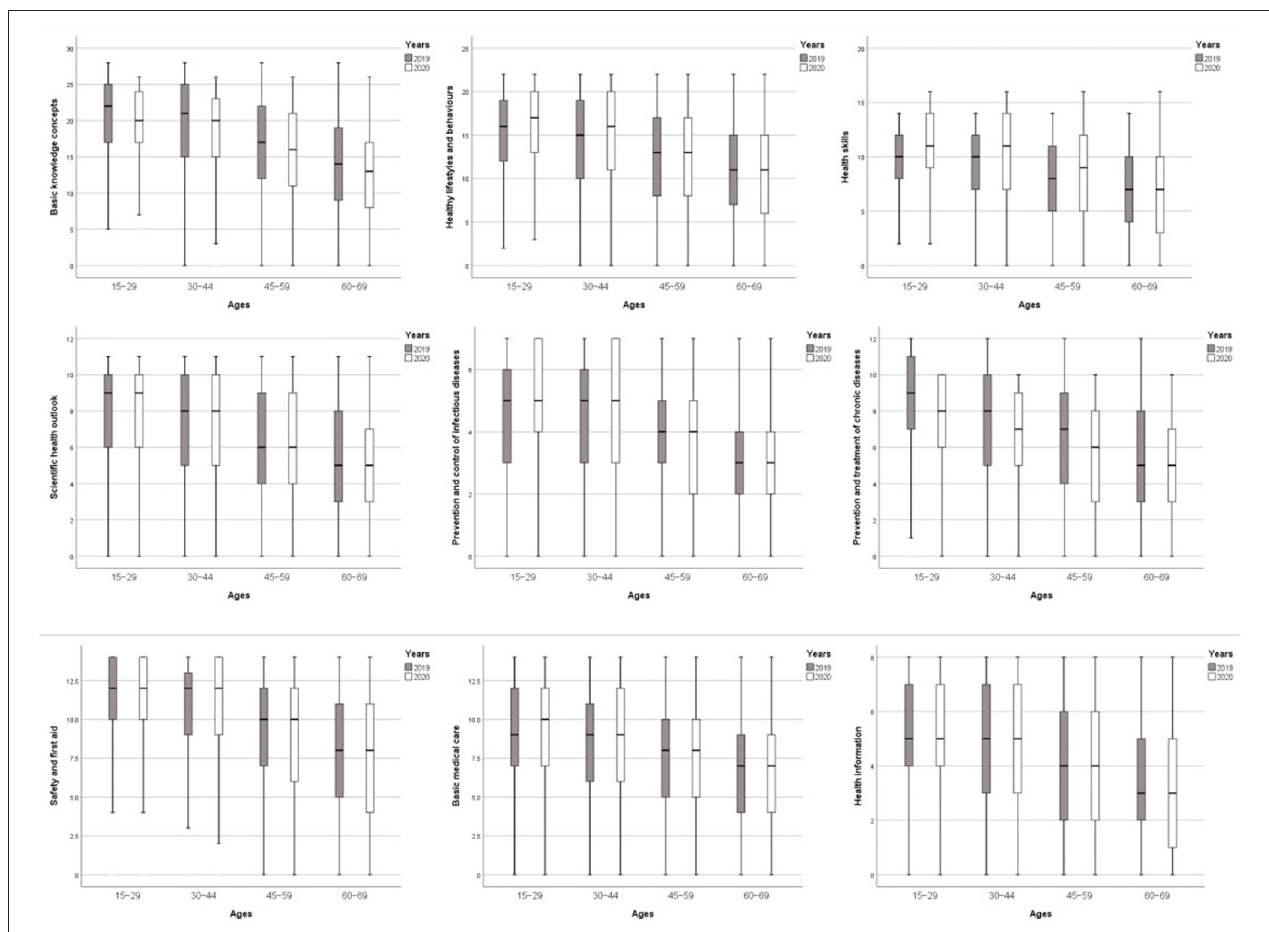
FIGURE 2 | Trends in the scores of the “3 aspects and 6 problems” health literacy at each